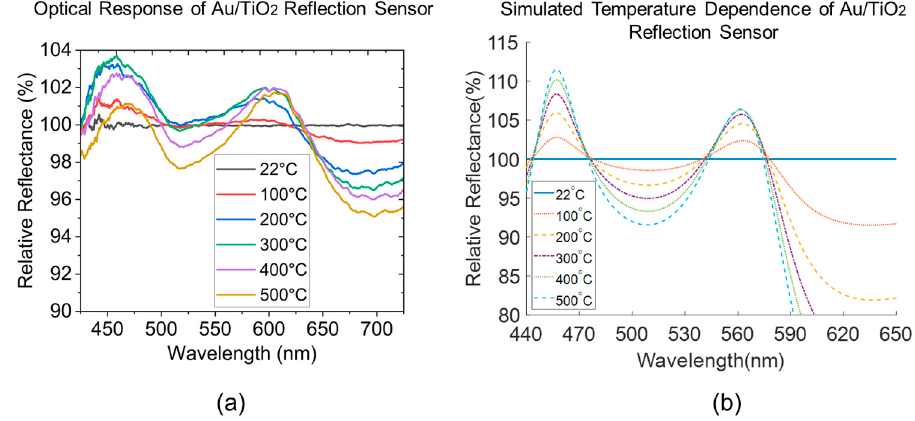
Figure 10. ( a ) Experimental results of the optical response of an Au/TiO 2 plasmonic reflection sensor under temperature sensing test. ( b ) Simulated optical response to temperature of the same using the optical waveguide model.